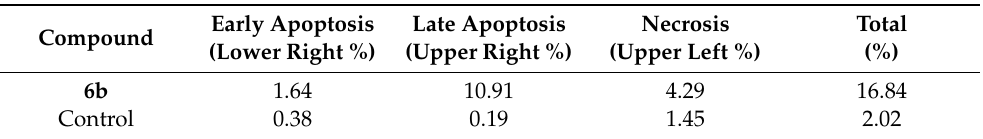
Table 6. Distribution of the apoptotic cells in the Annexin V-FITC/PI dual-staining assay in HepG2 cells after treatment with compound 6b